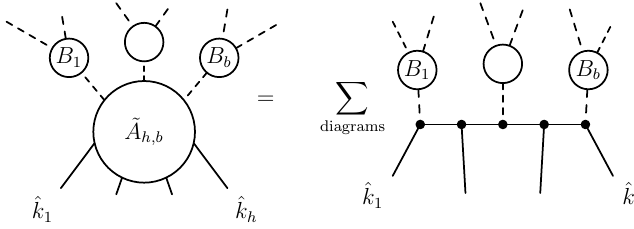
Figure 1 . Illustration of the skeleton and background amplitudes appearing in (4.2). The shifted momentum (cid:13)ows through solid lines while dashed lines denote background